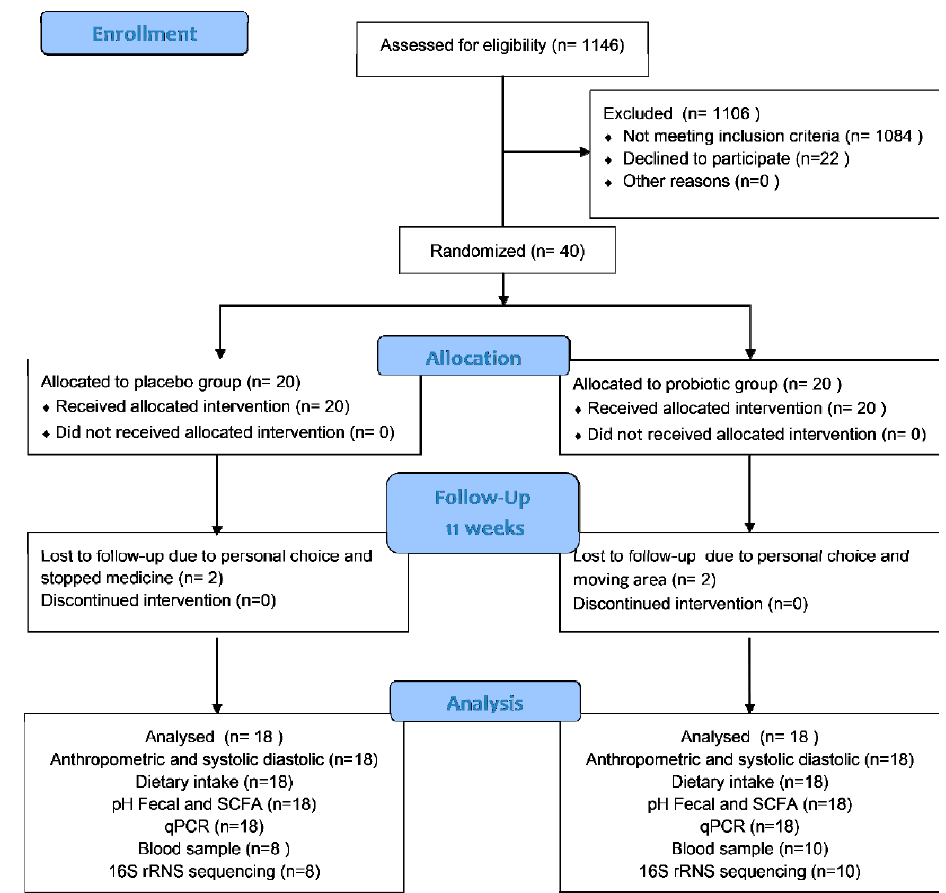
Figure 1. Participant flow according to CONSORT. Table 2. Characteristic of study subjects at baseline.